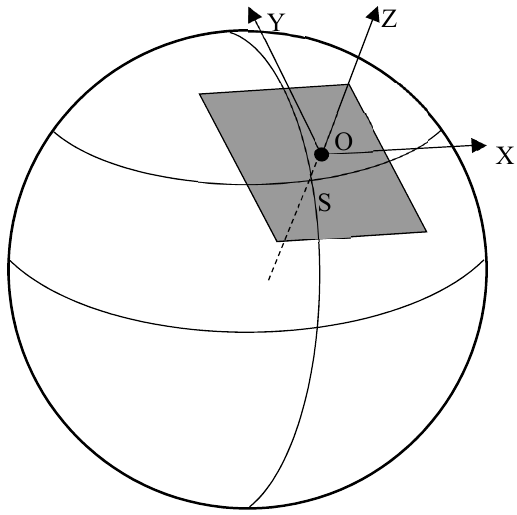
Figure 2. Definition of the local Cartesian coordinate system.